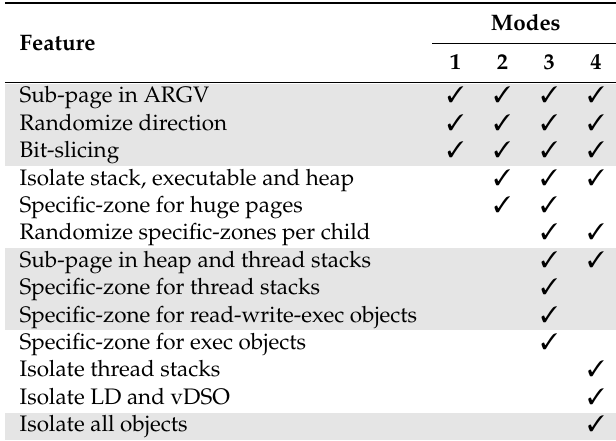
Table 3. ASLR-NG mode